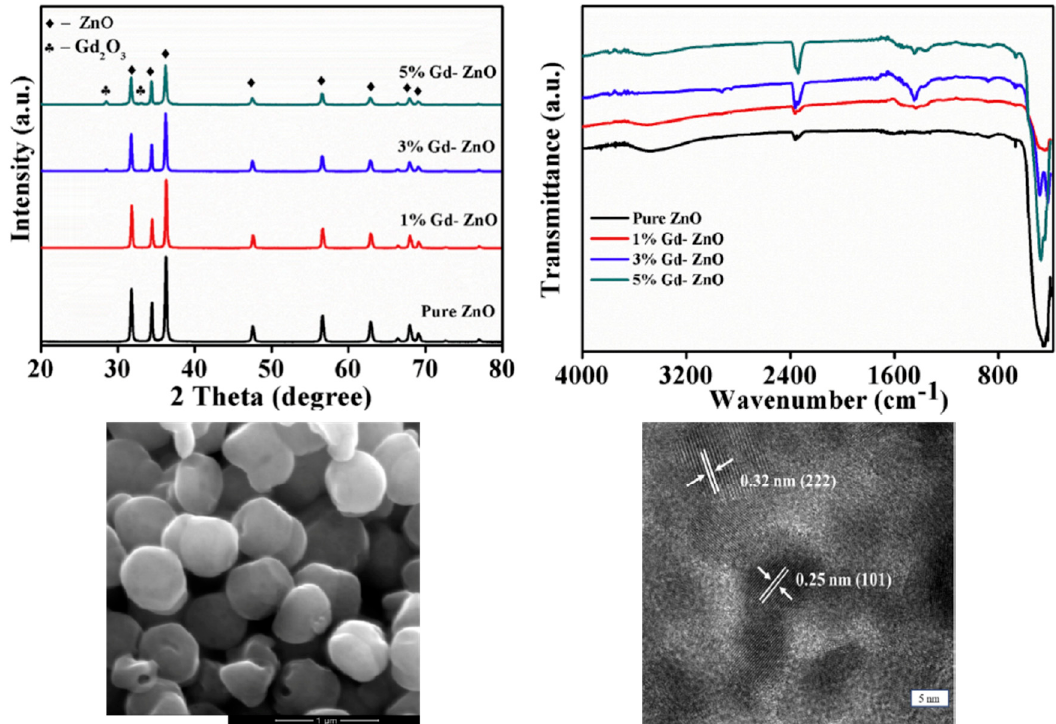
Figure 4. Characterization of gadolinium-doped ZnO nanoparticles. From left to right and top to bottom: XRD patterns and Fourier transform infrared spectroscopy (FTIR) spectra of the nanostructures at different doping levels, scanning electron microscope and transmission electron microscope images of 3% Gd-doped ZnO nanoparticles. Adapted from ref. [177] .